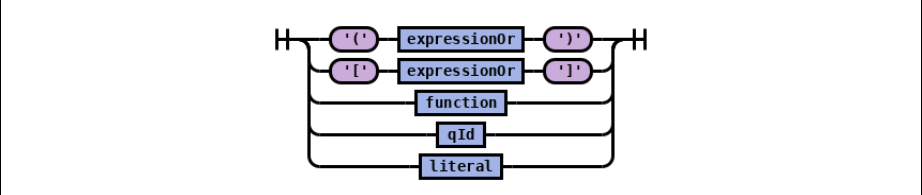
Figure 3. MQL has normal expression groups with parentheses and isolated expression groups with square brackets in order to produce SQL embedded sub-queries